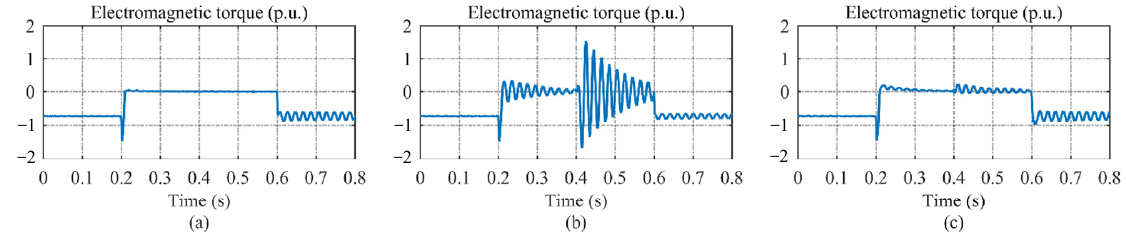
Figure 12. Simulation results of three-phase grid voltage sag of 80%. ( a ) DISC. ( b ) Method-1. ( c ) Method-2.